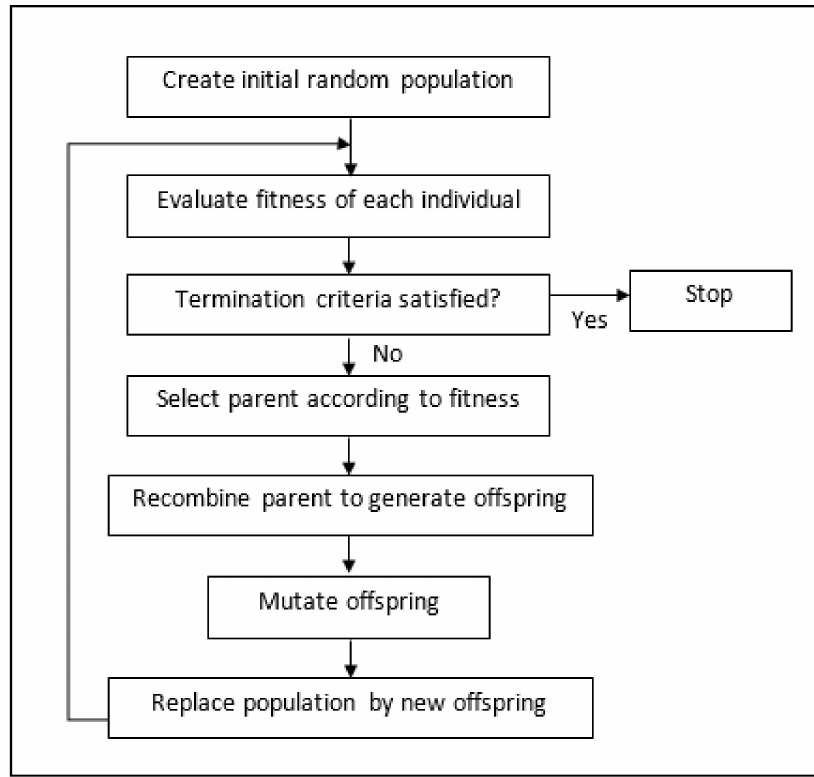
Figure 12. GAs evolutionary